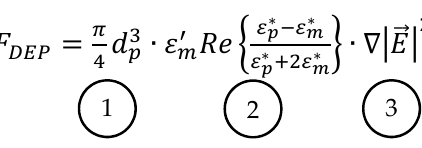
Figure 2. Simulation of dielectrophoresis (DEP) cell separation in a microfluidic flow. ( a ) before and ( b ) after microalgae Chlamydomonas reinhardtii have passed a deflector electrode configuration (top and bottom